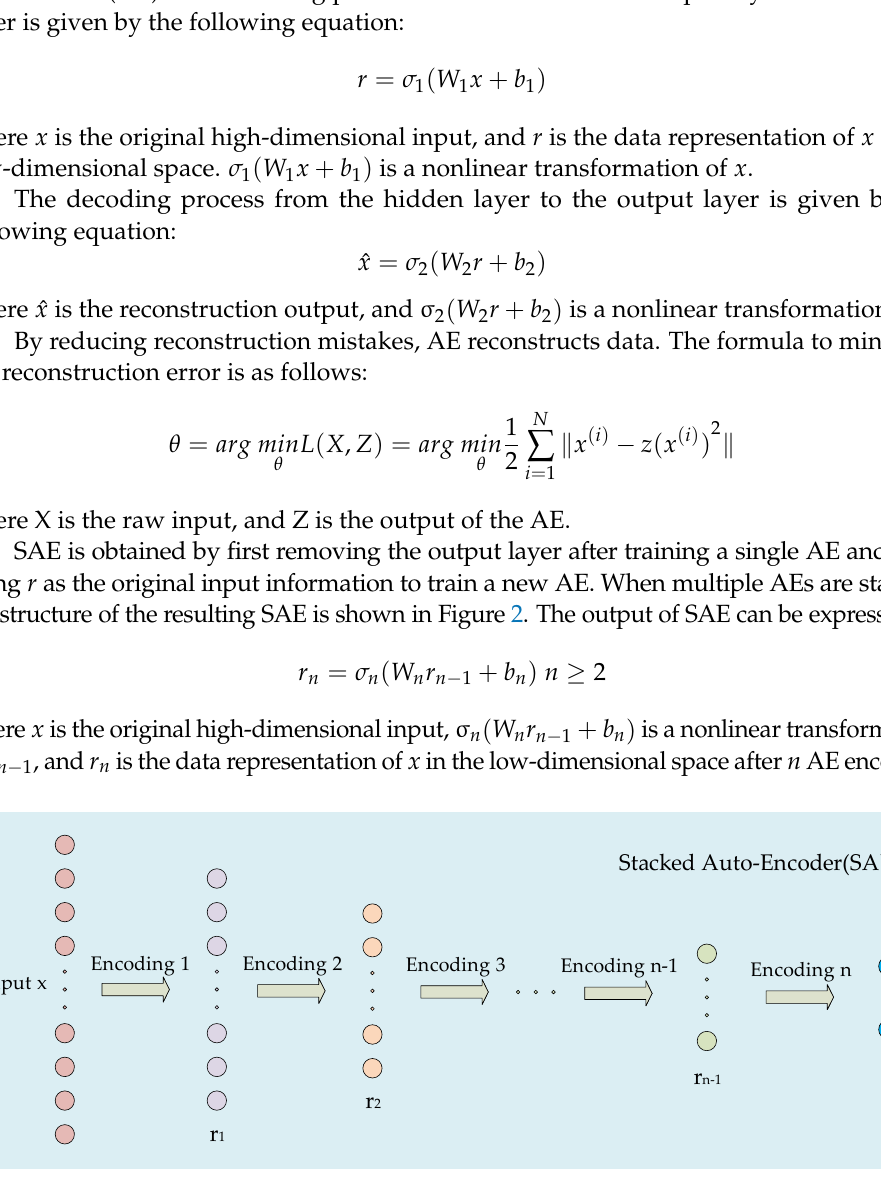
Figure 2. Structure of